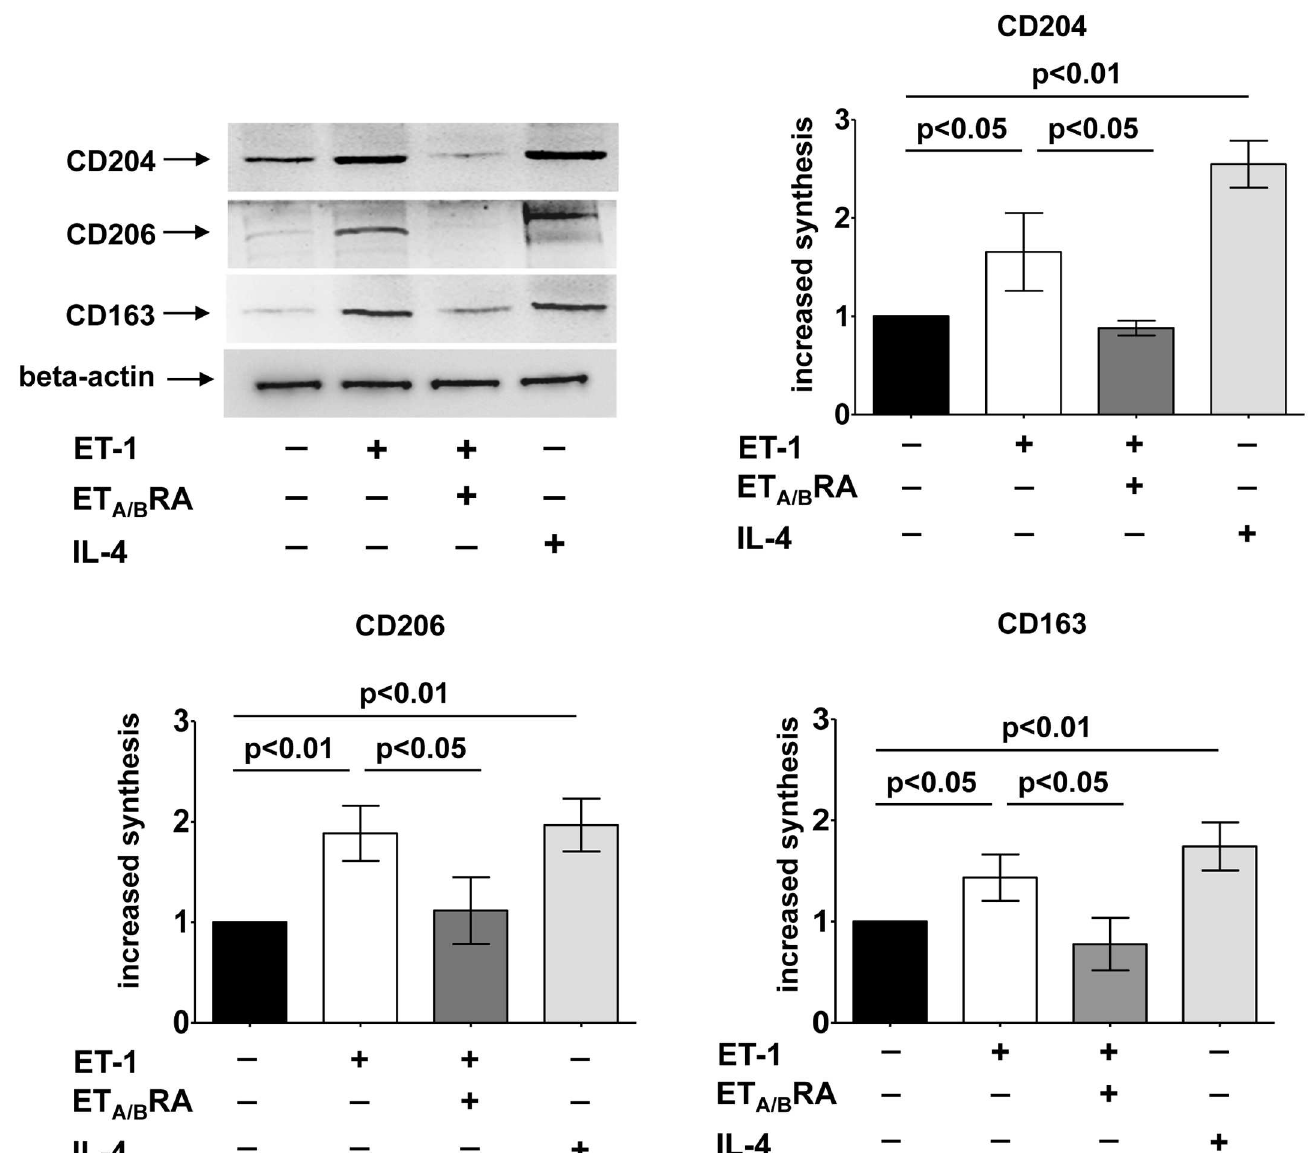
Fig 3. Evaluation of protein synthesis of M2 phenotype markersin cultured THP-1-derived macrophages. Western blotting and related densitometric analysisof CD204, CD206 and CD163 protein synthesis in culturedTHP-1-derived macrophages (M0 macrophages) treated for 72 hours with ET-1 (100nM) and IL-4 (10ng/mL) alone, or pre-treatedwith ET A/B RA (bosentan, 10 -5 M) for 1 hour before beingstimulatedwith ET-1. CulturedM0 macrophages maintainedfor 72 hours in RPMI at 5% of FBS were used as controls (M0-controls). Western blotting was performed on six independent in vitro experiments. The data of CD204, CD206and CD163 protein synthesis are shown as mean ± SDand indicatedas increase in protein synthesis.